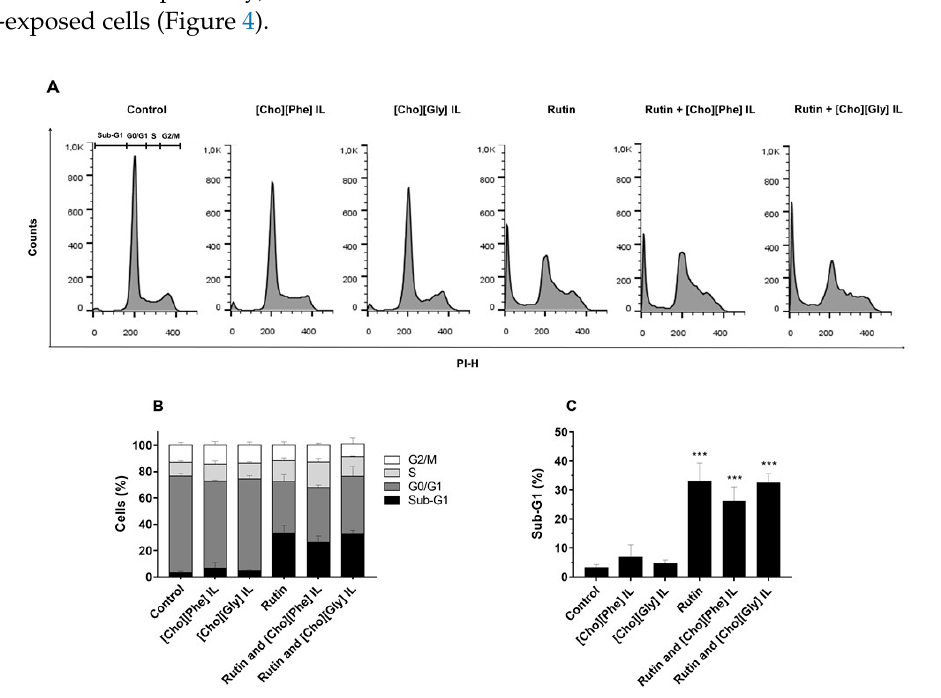
Figure 4. Effect of rutin and ILs, individually and combined, on cell cycle progression of 786 ‐ O cells. Cellular DNA content was analyzed by flow cytometry after 48 h incubation with rutin (50 μ M) and/or each IL, [Cho][Phe] IL (0.3%) or [Cho][Gly] IL (0.2%). Representative flow cytometry histograms ( A ), Sub-G1, G0 / G1, S and G2 / M populations summary results ( B ) and Sub-G1 population percentage ( C ). Values represent mean ± SD ( n = 3–6); *** p < 0.001 ( one ‐ way ANOVA, Tukey’s test, relative to control cells ).